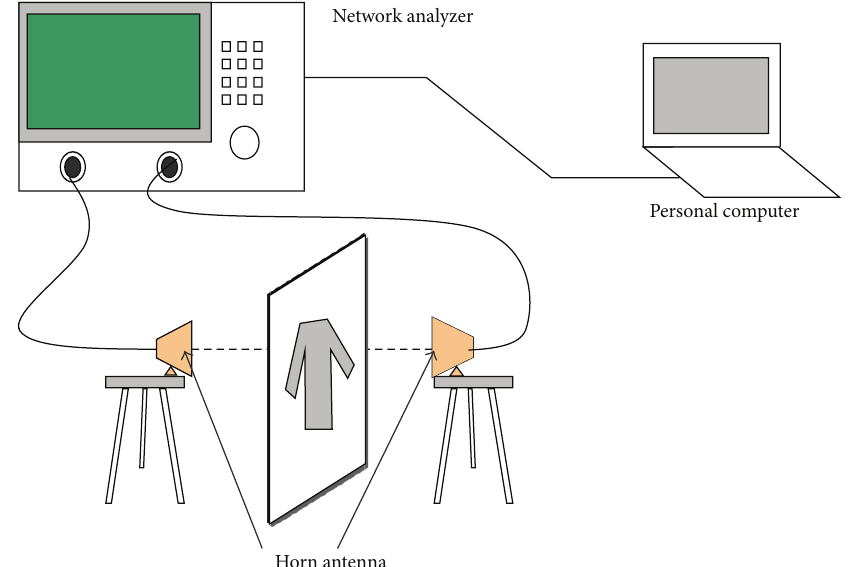
Figure 1: Microwave test bench for transmission measurements through clothing.